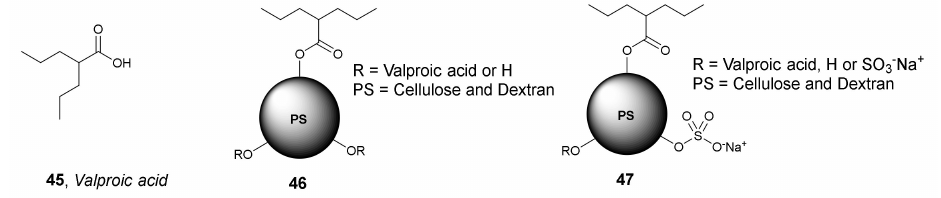
Figure 22. Chemical structures of valproic acid 45 and its polysaccharide-based NPs 46 and 47 . In 2021, Chaudhuri et al. synthesized novel cyclodextrin (CD)-based nanoparticles containing β -amino ester and PEG units for the encapsulation of HDACis [75]. One